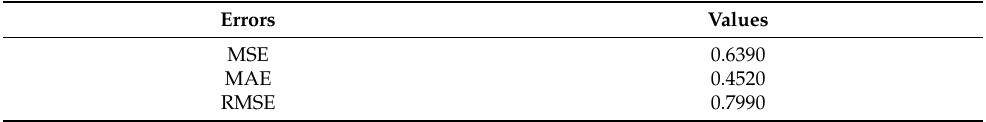
Figure 5. ( a ) Error and ( b ) relative error of solar radiation prediction using ARMA (3,3) (winter day). Table 2. MSE, MAE, and RMSE (winter